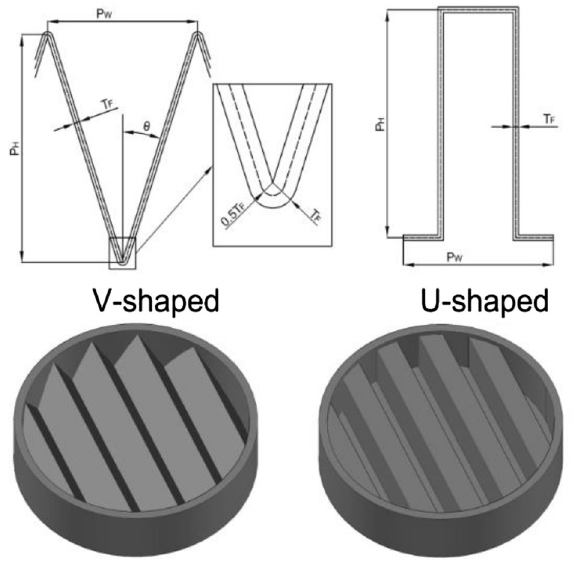
Figure 2. Filters with different geometries.